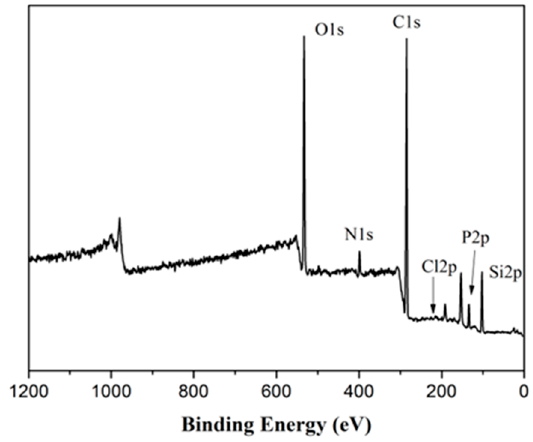
Figure 2. The XPS spectrum of the synthesized HSPCTP. Table 1. Elemental data of HSPCTP.